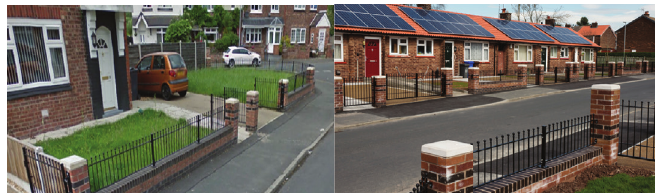
Figure 4: City West Housing Trust “environmental” scheme after works. Source :